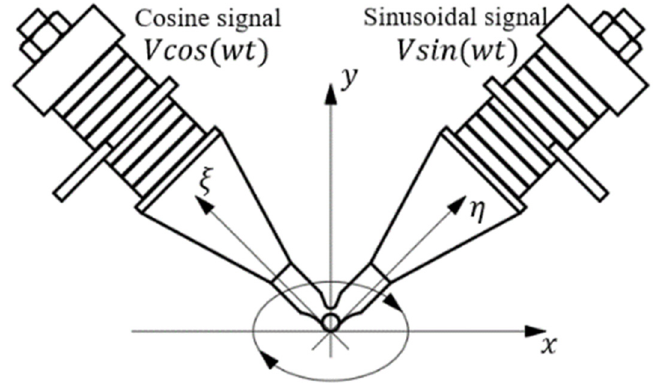
Figure 3. Excitation mode of the V-shape vibrator and ellipse track of the driving tip. Formula (3) is an elliptic trajectory equation. θ is the angle between the x -axis and η -axis, which is generally 45 ◦ .